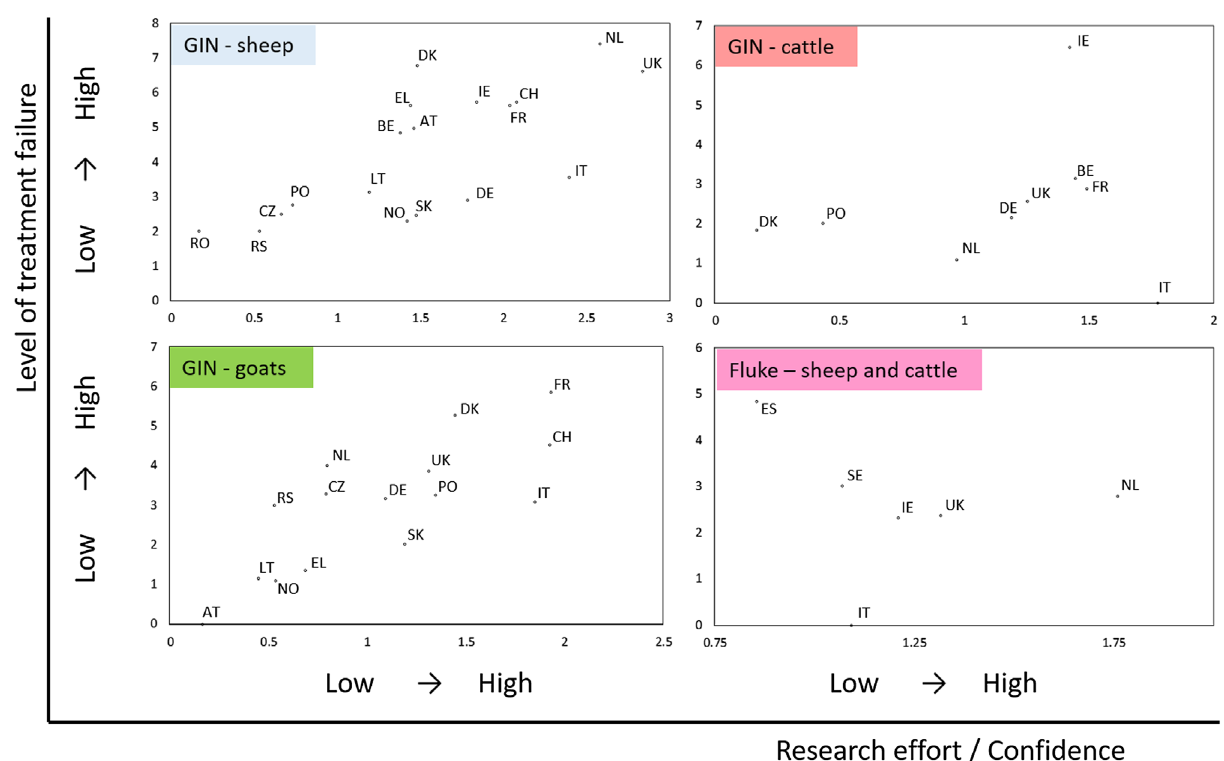
Figure 4. Level of anthelmintic resistance in each country, using a composite index across all drugs tested, in relation to research effort (= con fi dence) as a function of number of studies, farms and anthelmintics investigated. See methods for details of indices. Note that horizontal scales are different for each panel. For gastrointestinal nematodes in sheep in Ireland, the con fi dence score was modi fi ed to take account of a single large study that assessed treatment ef fi cacy through pooled faecal sampling by farmers at and after treatment [54]. GIN = Gastrointestinal nematodes. Country abbreviations: AT = Austria, BE = Belgium, CH = Switzerland, CZ = Czechia, DE = Germany, DK = Denmark, EL = Greece, ES = Spain, FR = France, IE = Ireland, IT = Italy, LT = Lithuania, NL = Netherlands, NO = Norway, PL = Poland, RO = Romania, RS = Serbia, SE = Sweden, SK = Slovakia, UK = United